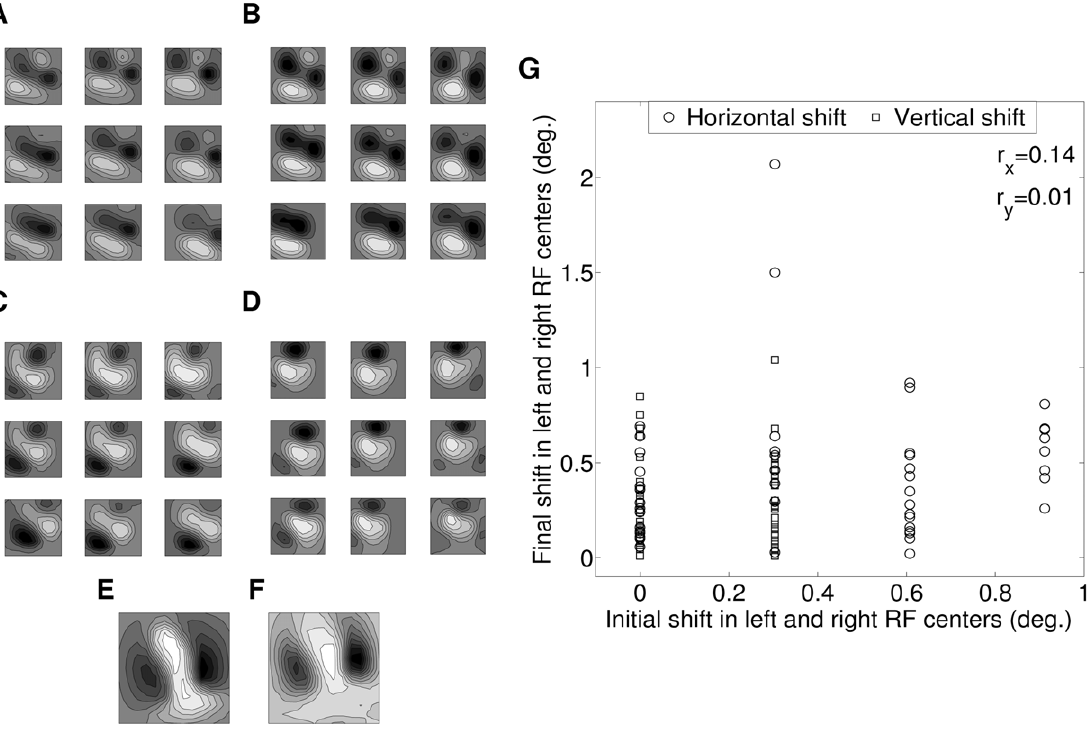
Figure 10. LGN cell activity, RF from Reverse correlation and Effect of initial RF center distribution. (A, B) 3 6 3 section of 2D left and right RFs from our model cortex. RFs are developed using the hypothesis that LGN cells are active during weight update. (C, D) 3 6 3 section of 2D left and right RFs from our model cortex. RFs are developed using LGN cell spontaneous activity as modeled by Goodhill [72]. (E) RF of a cortical cell as the set of LGN weights. (F) RF obtained using reverse correlation for the same cortical cell chosen in ‘E’. The RFs in ‘E’ and ‘F’ looks qualitatively similar. (G) Scatter plot of final versus initial shifts (horizontal and vertical) in VA of left and right RF centers for 50 cortical cells from our model cortex. doi:10.1371/journal.pone.0024997.g010 PLoS ONE |